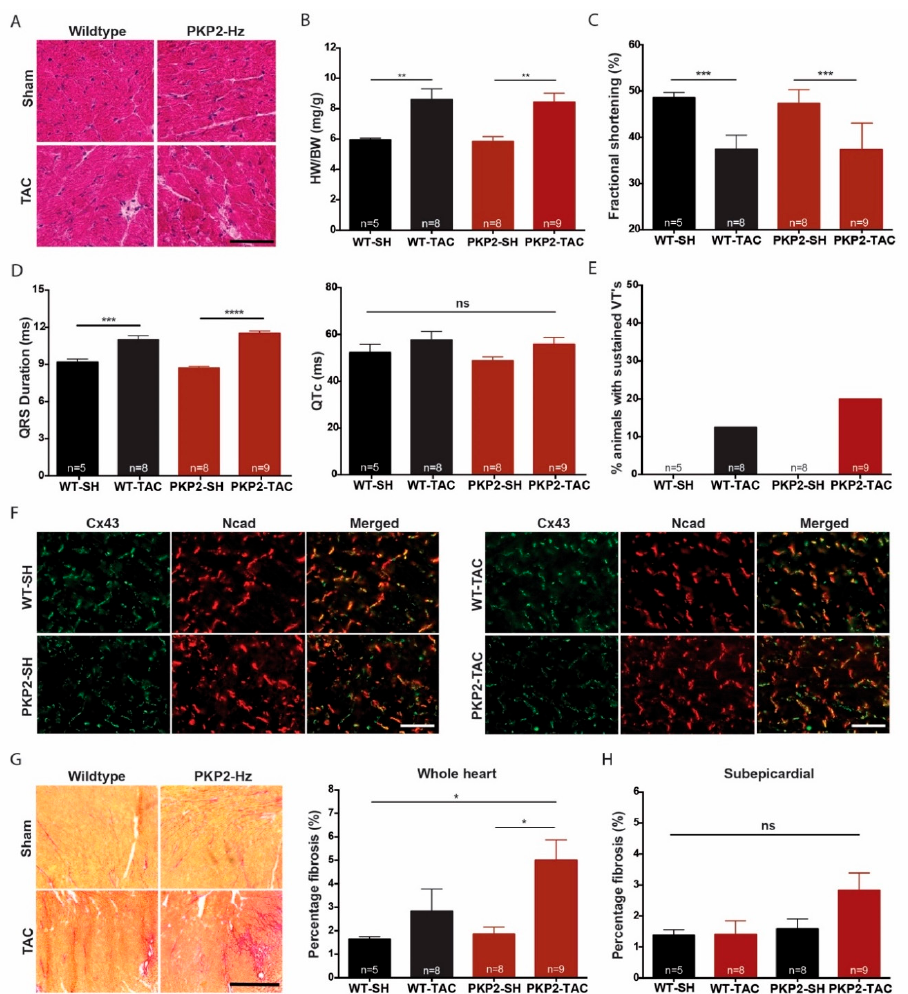
Figure 4. Pro-fibrotic cardiac remodeling in PKP2-Hz trans aortic constriction (TAC) operated mice. ( A ) Hematoxylin and eosin staining of wildtype and PKP2-Hz heart sections of Sham and TAC operated mice; scale bar, 100 µm. ( B ) Quantification of heart weight (HW) to body weight (BW) ratio in all four groups (WT Sham; n = 5, PKP2-Hz sham; n = 8, WT TAC; n = 8, and PKP2-Hz TAC; n = 9, mean ± SEM, ** p < 0.01). ( C ) Left ventricular fractional shortening examined by echocardiography in wildtype (WT) and PKP2-Hz mice after eight weeks of TAC/Sham surgery (WT Sham; n = 5, PKP2-Hz sham; n = 8, WT TAC; n = 8, and PKP2-Hz TAC; n = 9, mean ± SEM, *** p < 0.001). ( D ) QRS duration (left) and ventricular repolarization (QT) time corrected for heart rate (QTc; right) examined via electrocardiograms in wildtype (WT) and PKP2-Hz mice after eight weeks of surgery (WT Sham; n = 5, PKP2-Hz sham; n = 8, WT TAC; n = 8, and PKP2-Hz TAC; n = 9, mean ± SEM, *** p < 0.001). ( E ) Percentage of Langendorf-perfused hearts, within each group, susceptible for sustained ventricular arrhythmias by epicardial pacing (WT Sham; n = 5, PKP2-Hz sham; n = 8, WT TAC; n = 8, and PKP2-Hz TAC; n = 9). ( F ) Immunofluorescence staining for Cx43 (green) and Ncad (red) in wildtype and PKP2-Hz (PKP2) heart sections of mice exposed to Sham (SH) or TAC surgery; scale bar, 100 µm. ( G ) Representative pictures of Picrosirius red staining (left panel) in the inner myocardium of all four groups; scale bar, 500 µm. Quantification of collagen abundance (right panel) in overview slides of whole heart sections (WT Sham; n = 5, PKP2-Hz sham; n = 8, WT TAC; n = 8, and PKP2-Hz TAC; n = 9, mean ± SEM, * p < 0.05). ( H ) Quantification of collagen abundance (right panel) in the 0.2 mm subepicardial layer, examined in overview slides of whole heart sections (WT Sham; n = 5, PKP2-Hz sham; n = 8, WT TAC; n = 8, and PKP2-Hz TAC; n = 9, mean ± SEM).